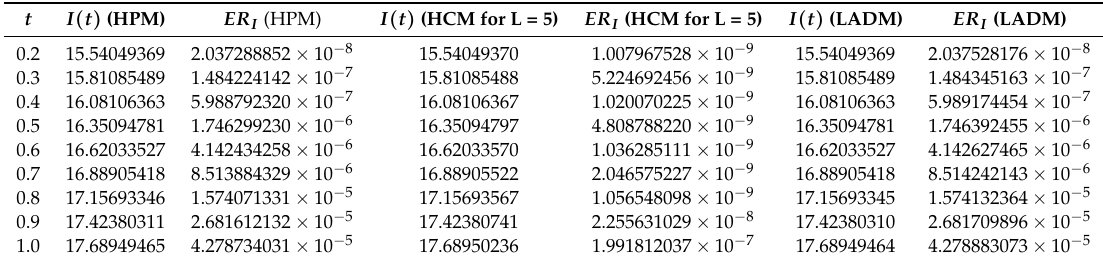
Table 2. The values of I ( t ) , and the residual errors ER I for HPM, HCM and